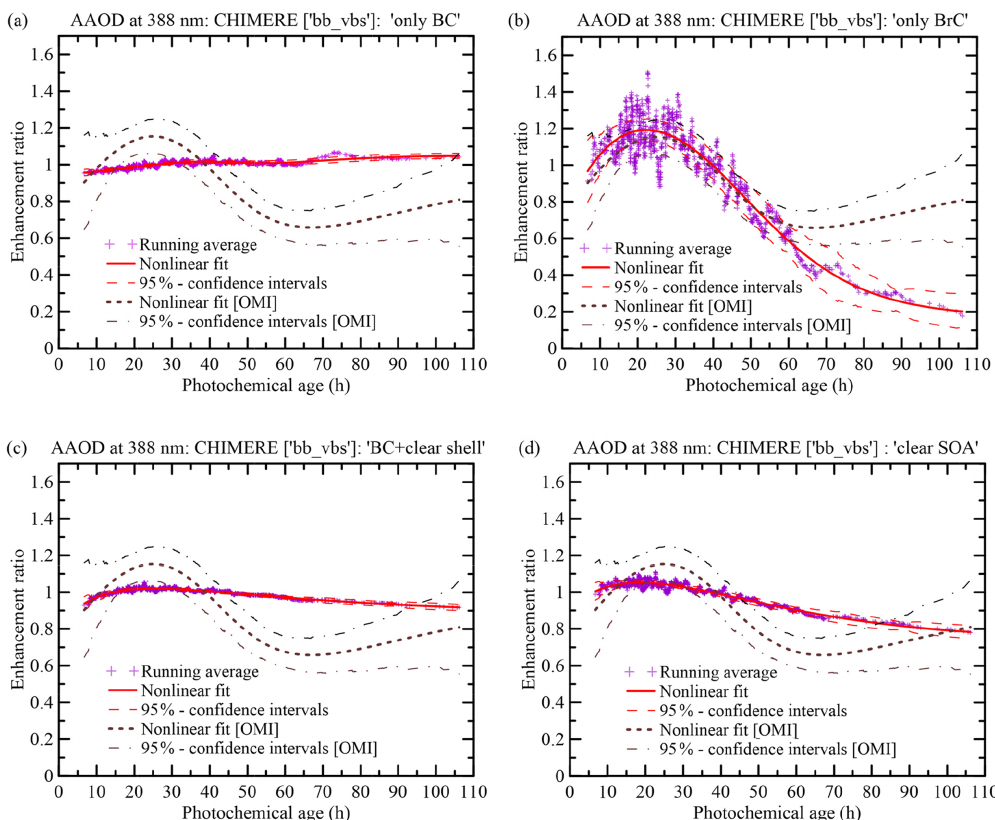
Figure 10. Evolution of EnR abs according to model results for several limiting cases involving different specifications of the optical prop- erties of the individual components of BB aerosol: (a) absorption is determined only by BC, (b) absorption is determined only by BrC, (c) absorption is determined only by the BC core surrounded by the non-absorbing shell, and (d) absorption is determined by both the BC core and OA shell, but SOA is non-absorbing. The trends in EnR abs according to the analysis of satellite observations (Fig. 5a) and the confidence intervals are also shown for comparison. The corresponding model results for the base case in which the BC core is surrounded by the absorbing shell are shown in Fig.